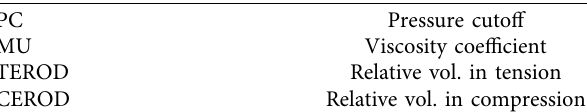
Table 4: Parameters to be